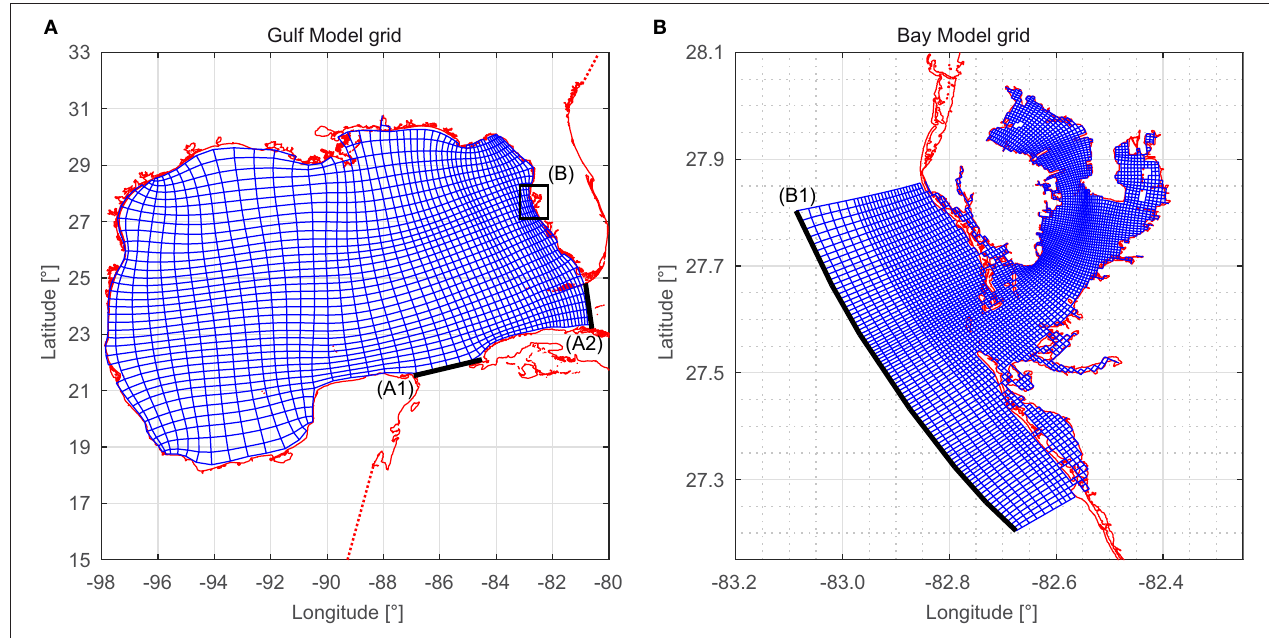
FIGURE 2 | Curvilinear grids (blue) and shoreline (red) used for the Gulf Model (A) and for the Bay Model (B). For clearness, the grids in this figure appear with a coarser resolution than used for the simulation. The Gulf Model grid (A) is actually two times higher resolved, the Bay Model grid (B) three times higher. Black lines indicate the model boundaries of the Gulf Model in the Yucatán Channel (A1), in the Florida Strait (A2) as well as the boundary toward the Gulf of Mexico in the Bay Model (B1).